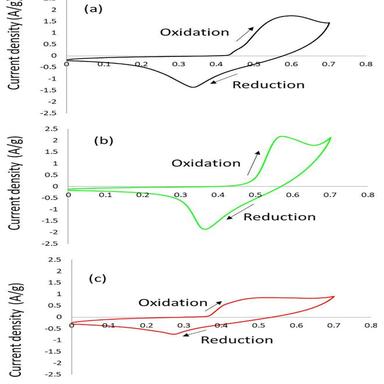
Cyclic voltammograms of (a) Ni(OH)2, (b) Ni0.95Mg0.05(OH)2 (c) Ni0.9Mn0.1(OH)2.